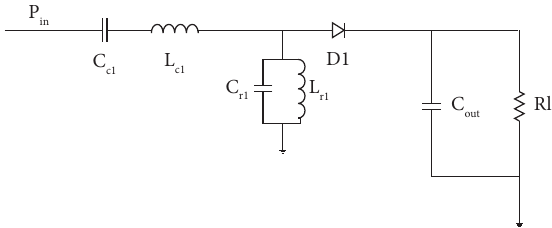
Figure 22: Rectifer only with one